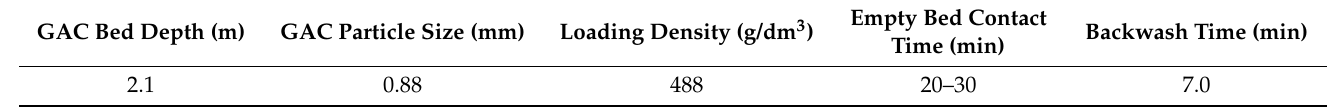
Table 1. Parameters of the BAC filters investigated in this study.